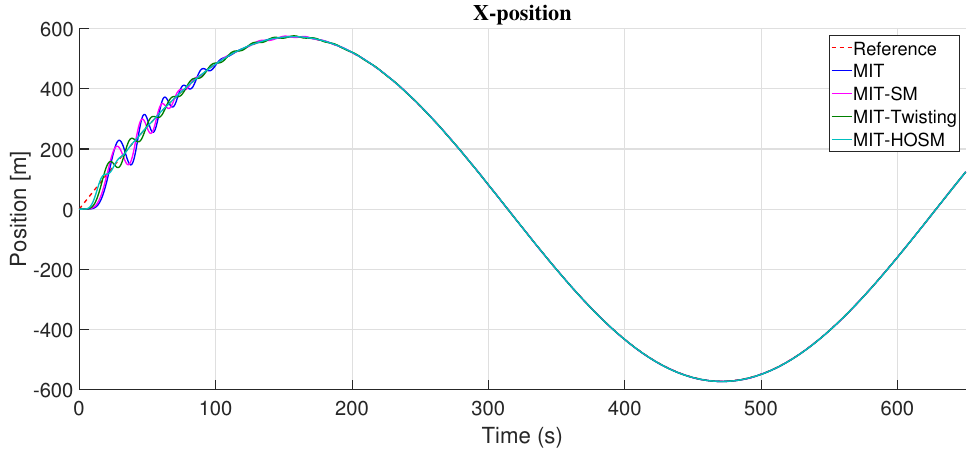
Figure 4. Trajectory following in axis-x.